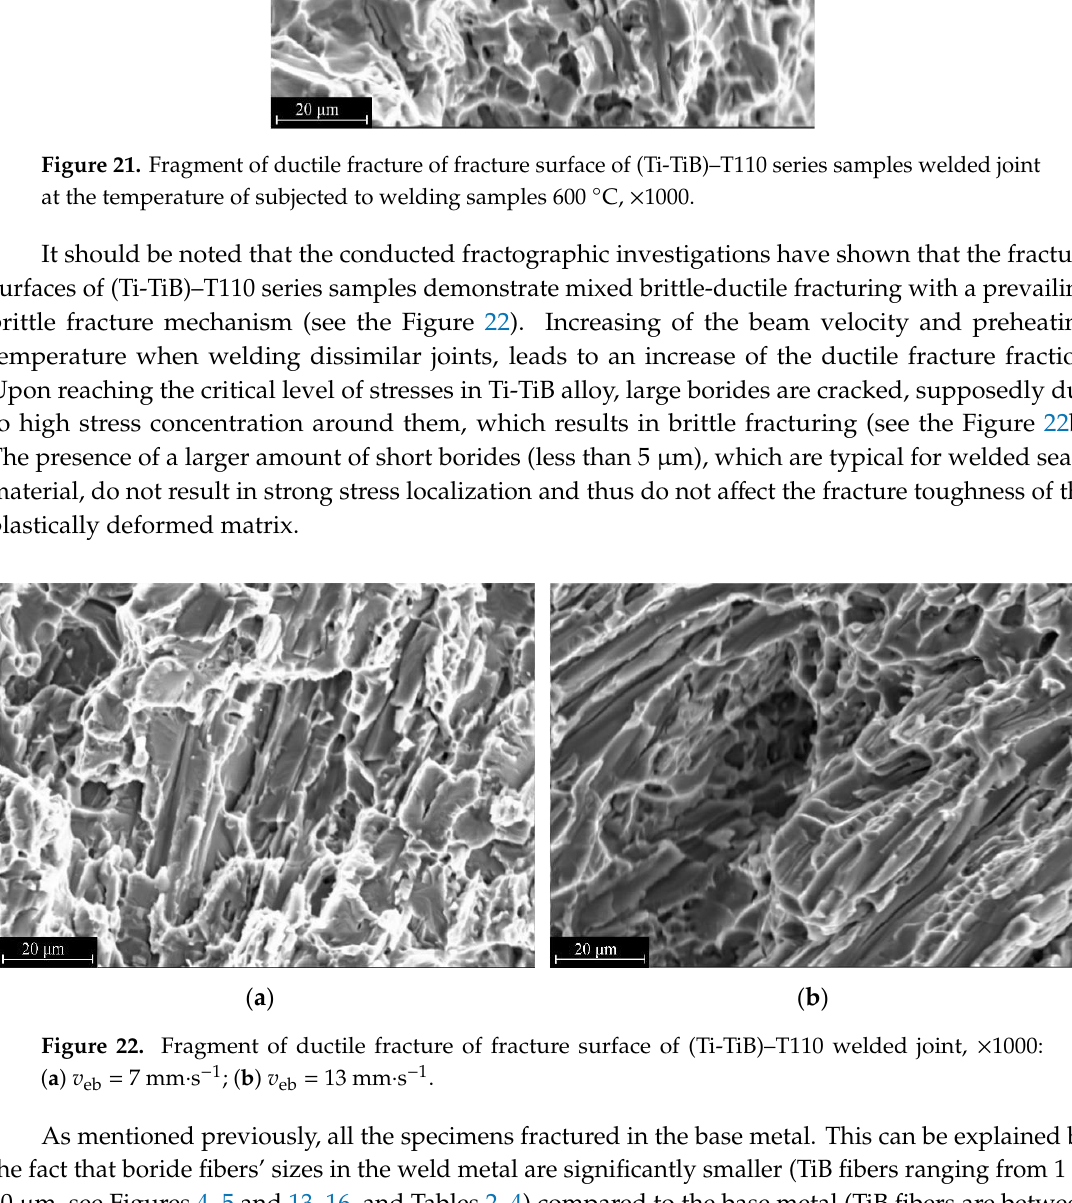
Figure 21. Fragment of ductile fracture of fracture surface of (Ti-TiB)–T110 series samples welded joint at the temperature of subjected to welding samples 600 °С, ×1000.